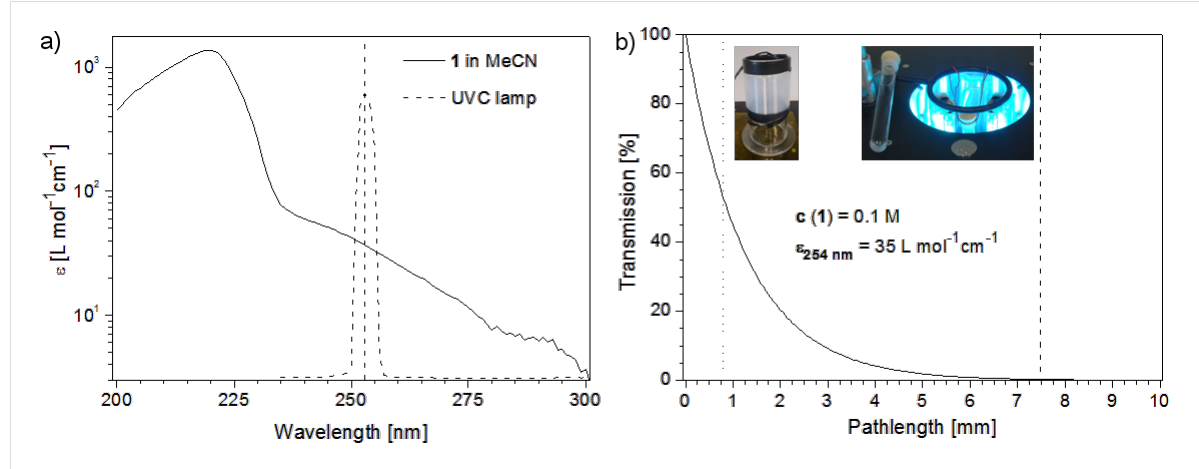
Figure 3: (a) UV-spectrum of 1 (in MeCN) vs emission spectrum of the UVC lamp. (b) Light-penetration profile for a 0.1 M solution of 1 at 254 nm. The vertical lines represent the effective pathlength in the test tube (---) vs the pathlength in the microcapillary (···).